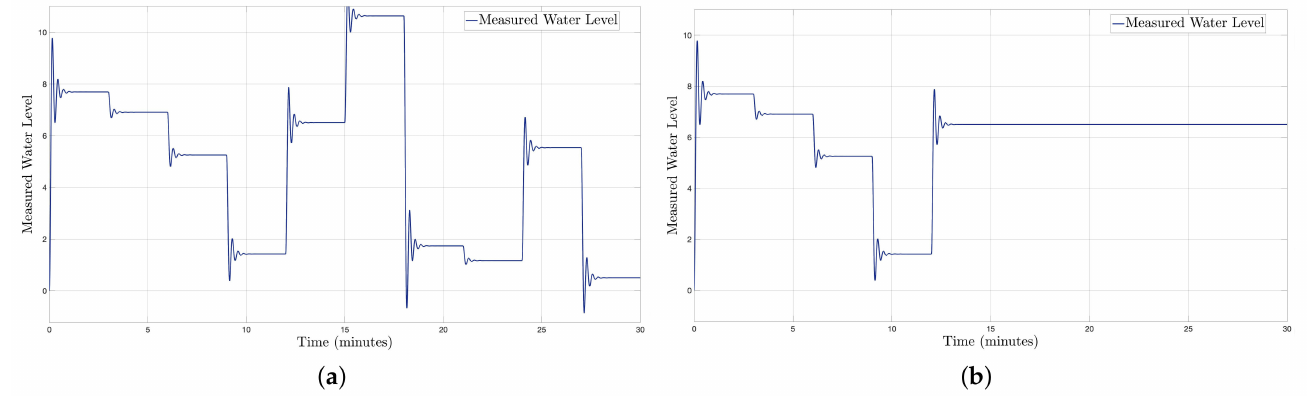
Figure 13. Measured Water Level Under Regular and Attack. ( a ) Measured Water Level Under Regular. ( b ) Measured Water Level Under